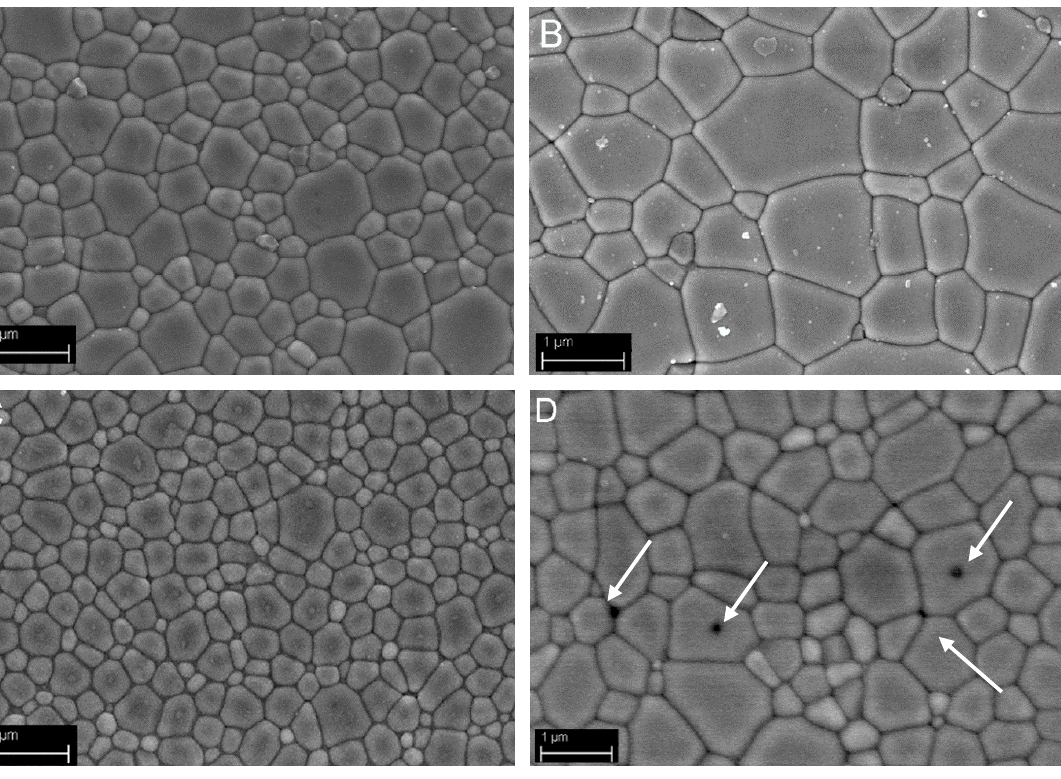
Figure 6. FESEM micrographs of YAG cl -AHC0.5 sintered at ( a ) 1500 °C/3 h and ( b ) 1600 °C/3 h and of ( c ) YAG n -AHC0.5 and ( d ) YAG cl -AA both sintered at 1500 °C/3